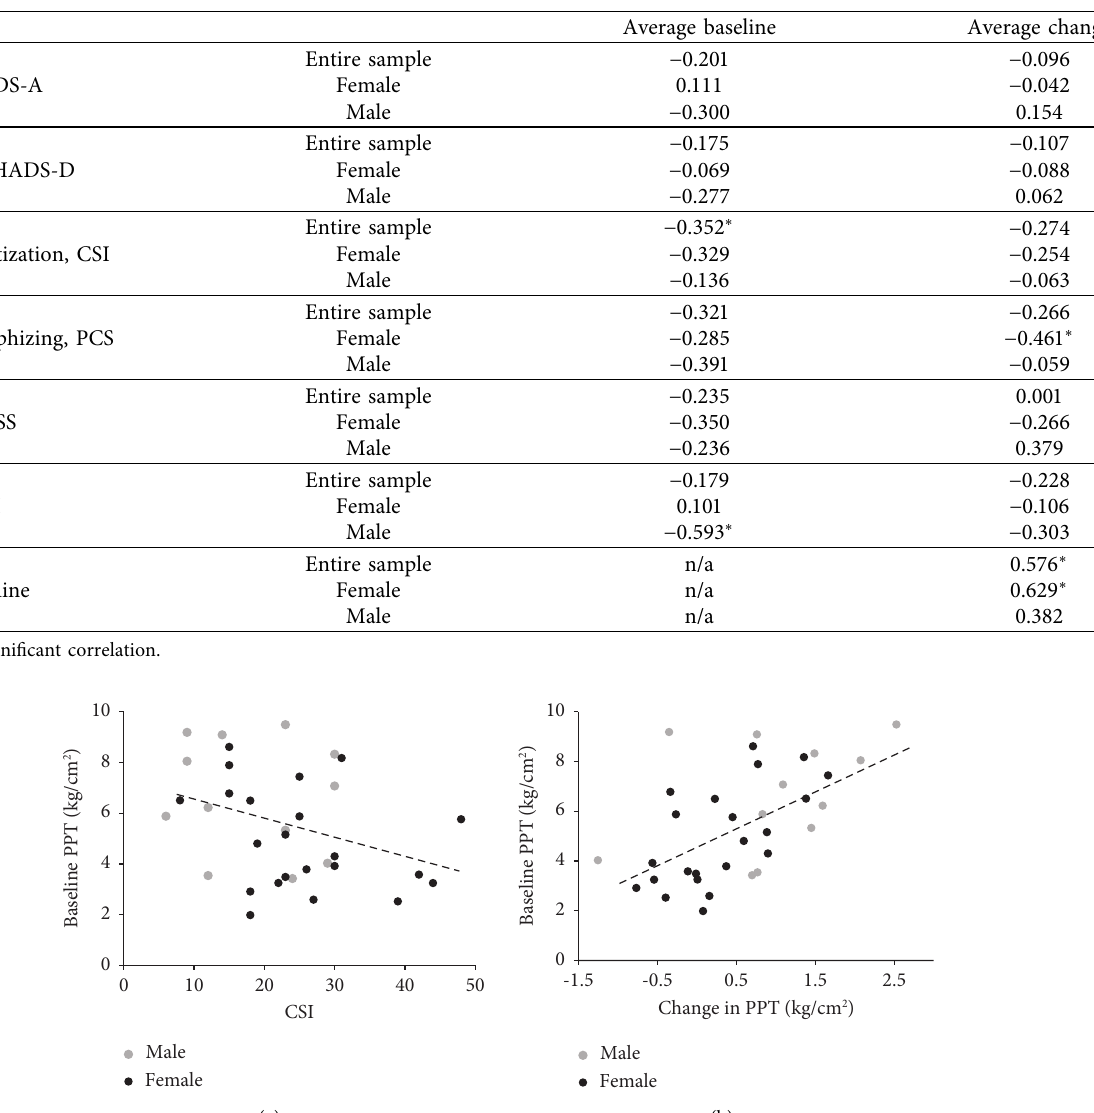
Table 2: Linear relationships between psychosocial factors, average baseline pressure pain threshold, and average change in pressure-pain threshold postfatigue.